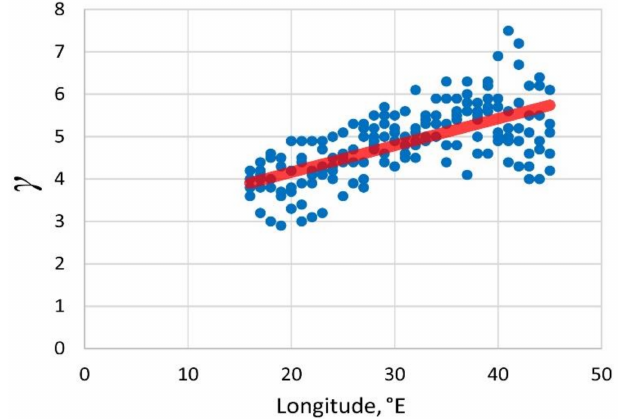
Figure 6. Distribution of the parameter γ (describing the samples belonging to the base distribution) in the west–east direction in the framework 67.5–75 N based on ERA5